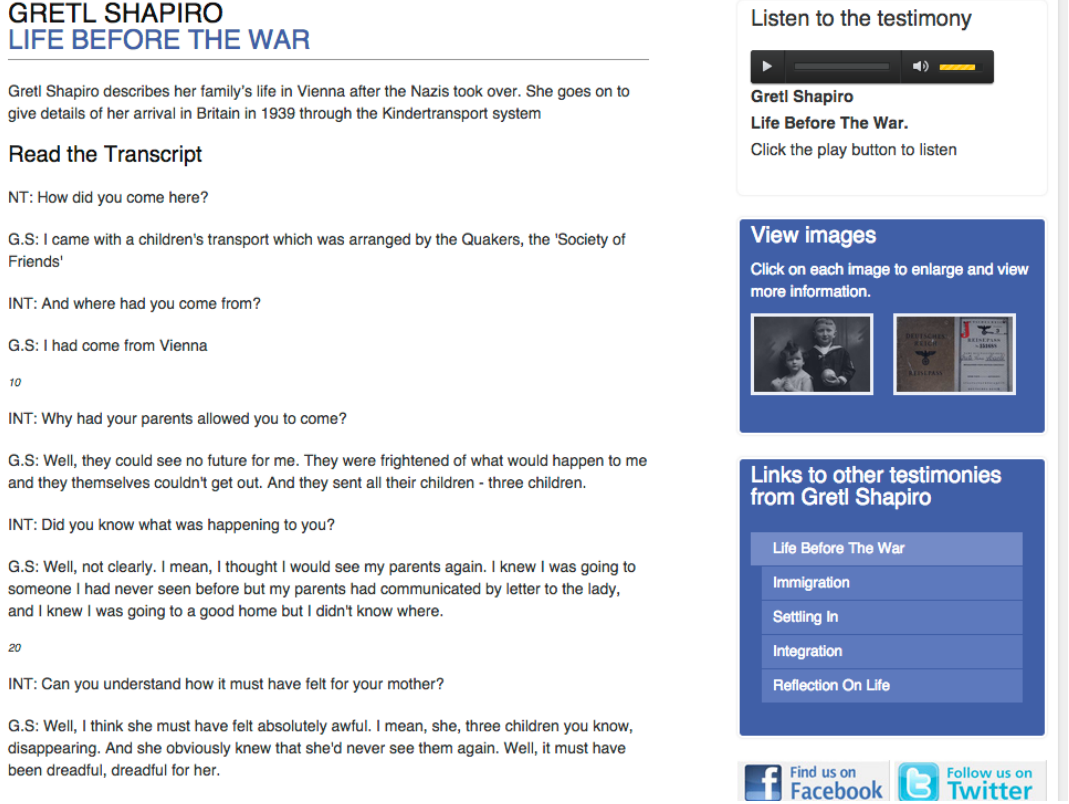
Figure 2. Extract of an interview from the Gathering the Voices